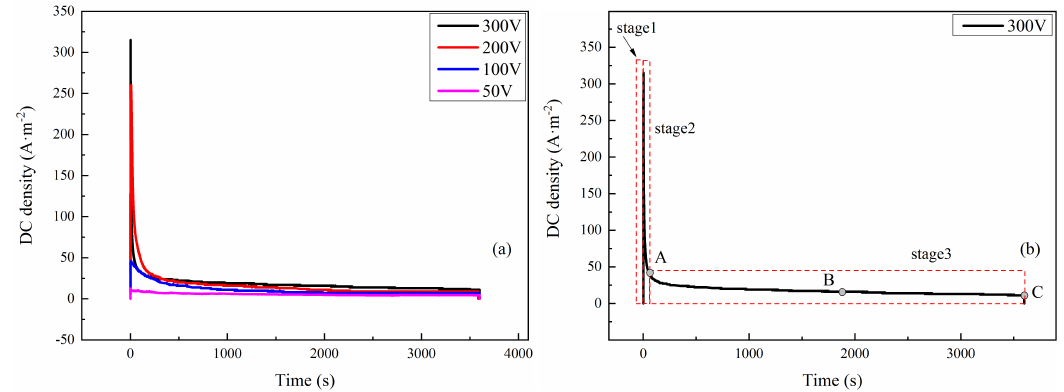
Figure 3. DC density–time transient of X80 coupons under 50–300 V ( a ) and 300 V DC voltages with three stages ( b